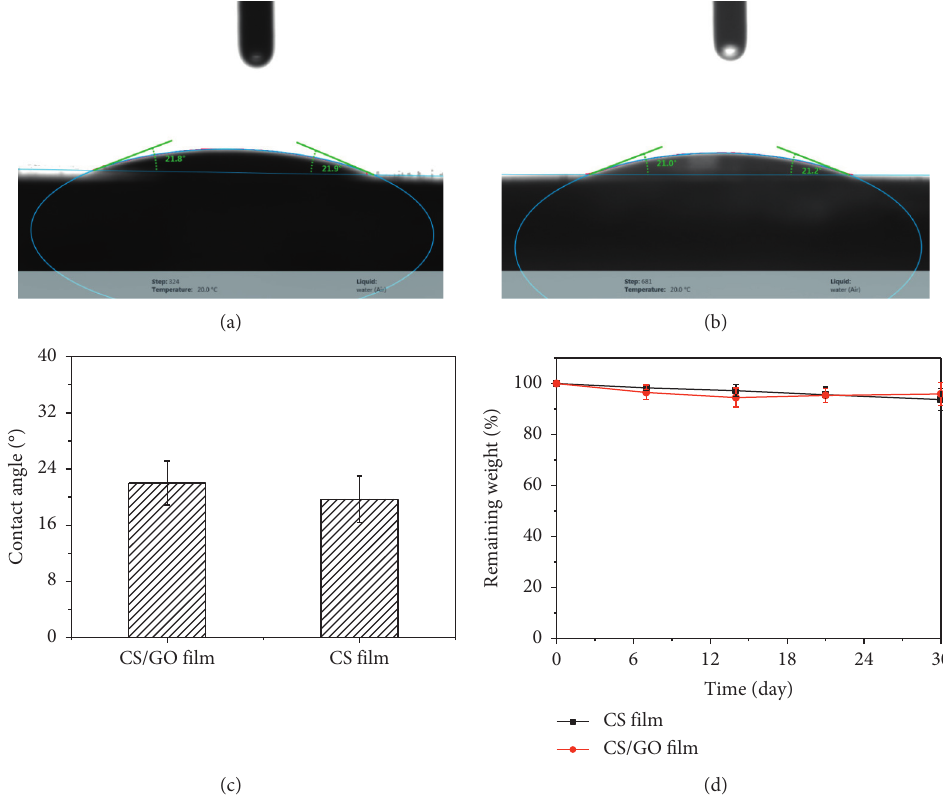
Figure 4: Photo of contact angle for (a) CS/GO film and (b) CS film; (c) contact angle value for CS/GO film and CS film ∗ p < 0 . 05, ∗∗ p < 0 . 01; (d) the remaining weight of CS film and CS/GO film as a function of degradation